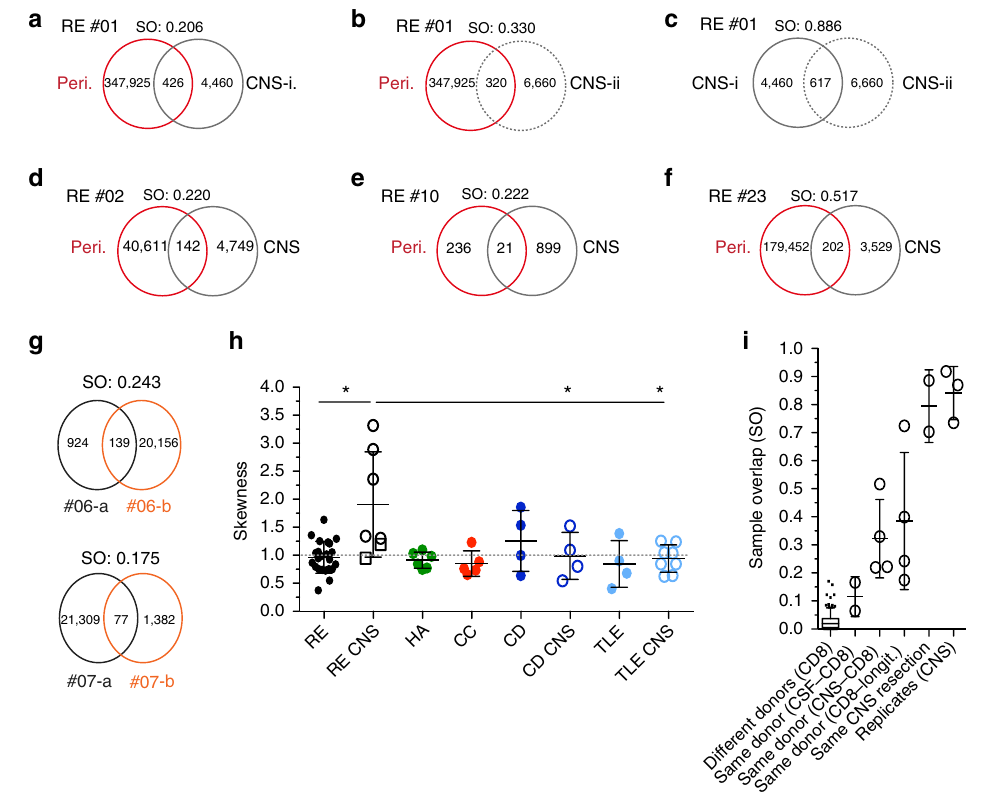
Figure 3 | Expanded CD8 þ T-cell clones shared between periphery and CNS. Shown are four RE patients with corresponding periphery and CNS samples. From patient RE #01 two CNS tissue resections were available. The Venn diagrams show the productive uniques of each sample, their shared productive uniques (shared clonotypes/CD8 þ T-cell clones), the SO and the top 10 shared clones of the respective sample comparison (given are amino- acid sequence, V b gene, J b gene and frequencies in the respective sample; clones are sorted by frequency in the CNS sample). ( a ) RE 01 CD8 þ periphery and CNS-i (first tissue resection), ( b ) RE 01 CD8 þ periphery and CNS-ii (second tissue resection), ( c ) RE 01 CNS-i and CNS-ii, ( d ) RE 02, ( e ) RE 10 and ( f ) RE 23. ( g ) Two RE patients where peripheral CD8 þ T-cell samples were available 1 year apart (a and b), ( h ) the skewness of the different patient groups and compartments described in Figs 1 and 2 (RE per. black, n ¼ 23; RE CNS black, n ¼ 7; HA green, n ¼ 6; CC green, n ¼ 5; CD dark blue, n ¼ 4; CD CNS dark blue, n ¼ 4; TLE periphery (per). light blue, n ¼ 4; TLE CNS light blue, n ¼ 8). Closed circles indicate peripheral CD8 þ T-cell samples, open circles indicate CNS tissue specimen and open squares indicate CSF samples (mean ± s.d., unpaired t -test with Welch’s correction). ( i ) Comparison of SOs between CD8 þ compartments of different donors ( n ¼ 231, longitudinally (longit.) whiskers: 5–95 percentile), CD8 þ and CSF of the same donor ( n ¼ 2), CD8 and CNS of the same donor ( n ¼ 4), CD8 þ from two time points and the same donor ( n ¼ 4), two tissue resections of the same donor’s brain tissue ( n ¼ 2), and the same CNS sample sequenced twice independently ( n ¼ 3) (mean ±